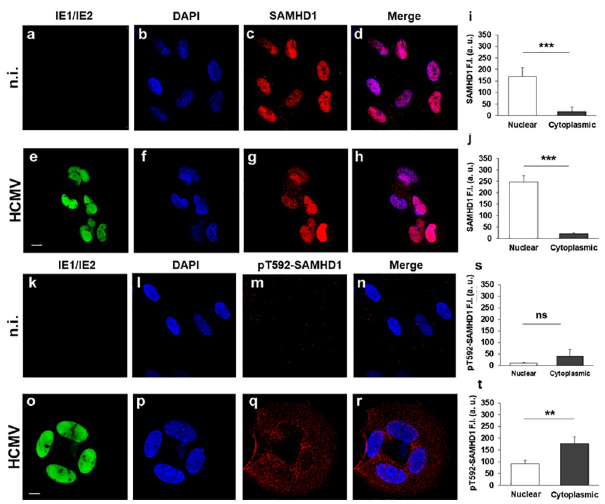
Fig 7. SAMHD1 intracellular localization in uninfected and HCMV-infected cells. HFFs were not infected (n.i.) or infected with AD169 at an MOI of 1 for 3 days. Stainings were then performed using primary antibodies directed against total (c and g) or pT592-SAMHD1 (m and q), followed by Alexa-Fluor 594 conjugated goat anti-rabbit (red), together with IE1/IE2 viral antigens followed by Alexa-Fluor 488 conjugated goat anti-mouse (a, e, k, o) (green) antibodies. Nuclei were stained with DAPI (b, f, l, p) (blue). Confocal images were acquired with a zoom 2 and are shown as single optical slice from one representative experiment out of six. An overlay of blue/red images (d, h, n, r) is also shown. Scale bar: 10 μ m. Fluorescence intensity (F.I.) of SAMHD1 (i-j) and p-T592 SAMHD1 staining (s-t) was calculated in the nucleus and cytoplasm of 80 cells randomly acquired from 3 independent experiments, as described in materials and methods. Histograms represent the mean ± SE. Displayed values are millions of a.u. ns, not statistically significant difference; �� p < 0.01; ��� p < 0.001.